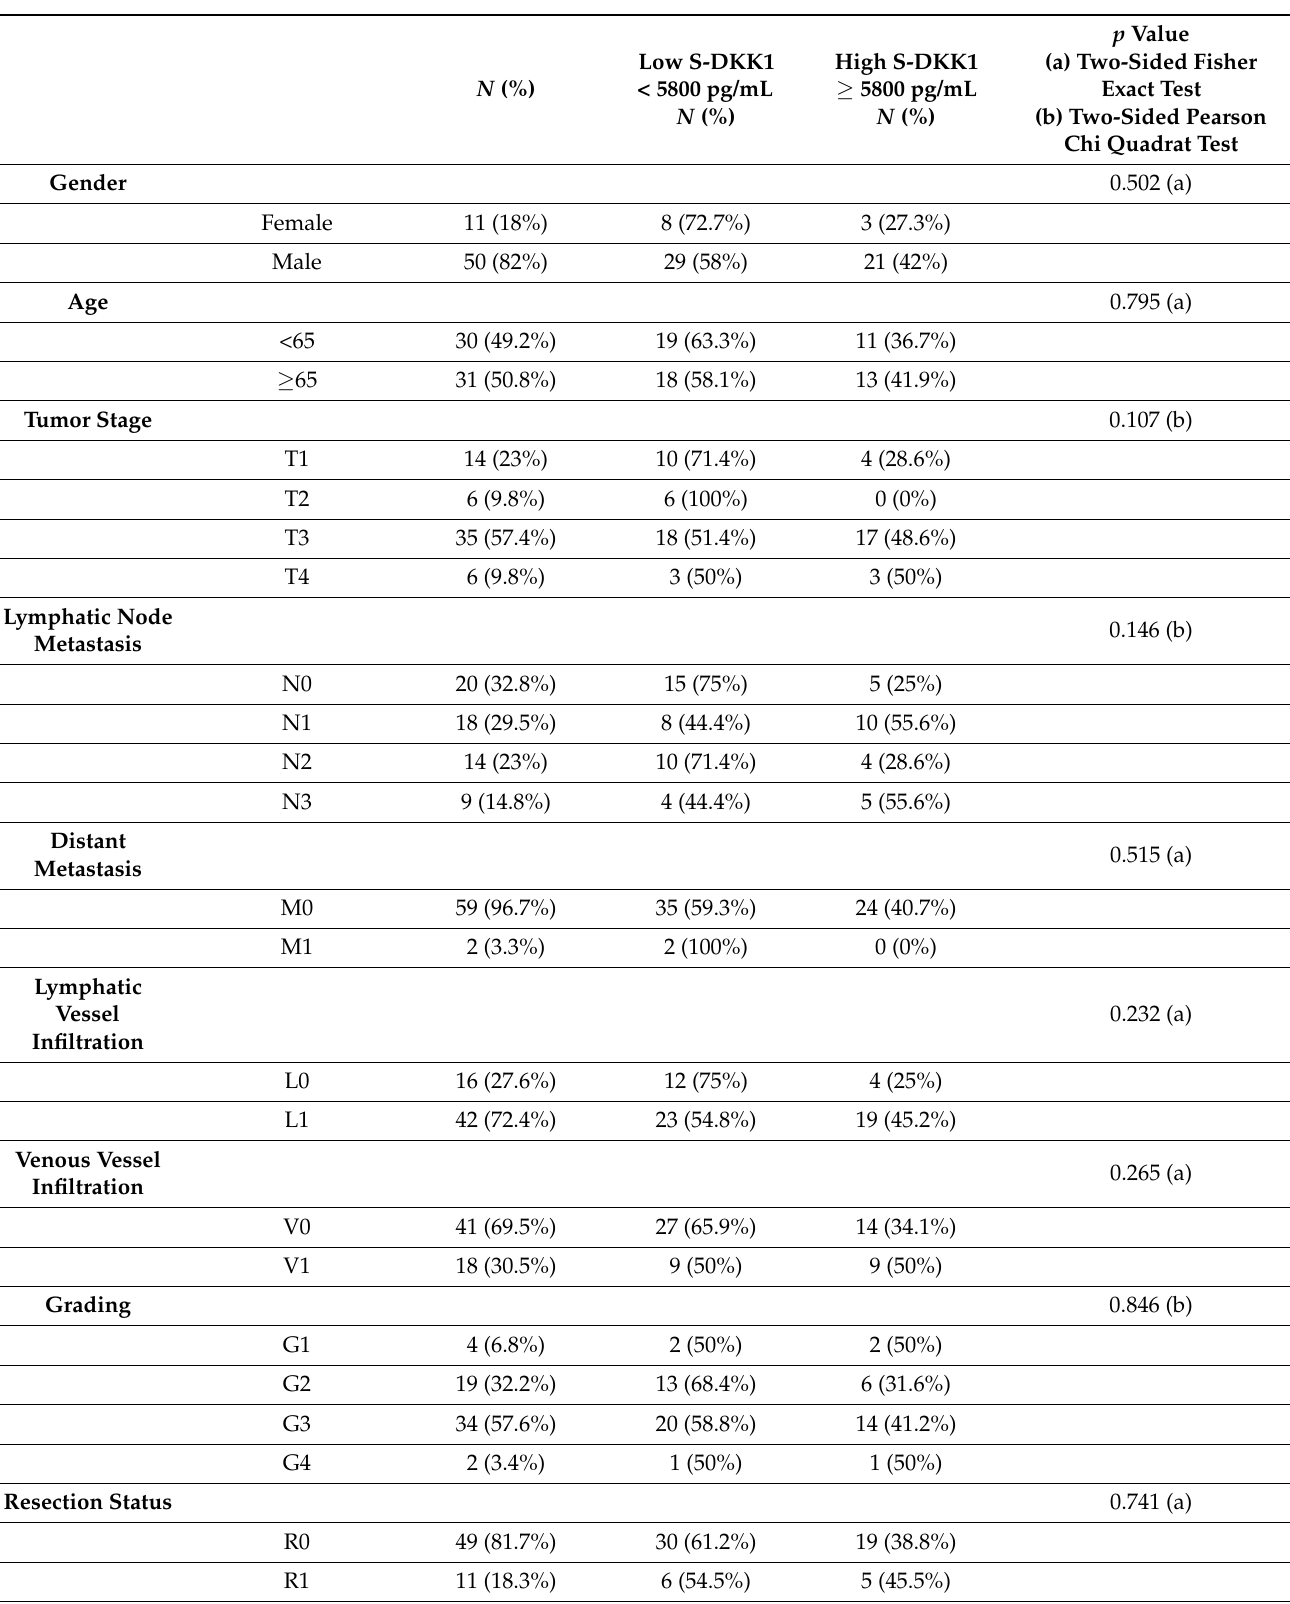
Table 3. Subgroup analysis of esophageal adenocarcinoma patients with respect to DKK1 serum